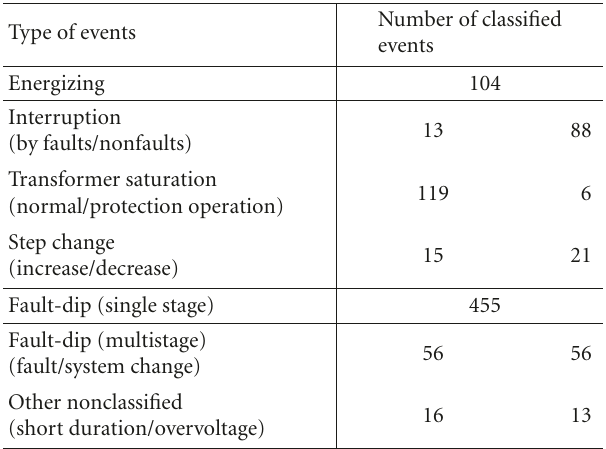
Table 1: Classification results for 962 measurements.